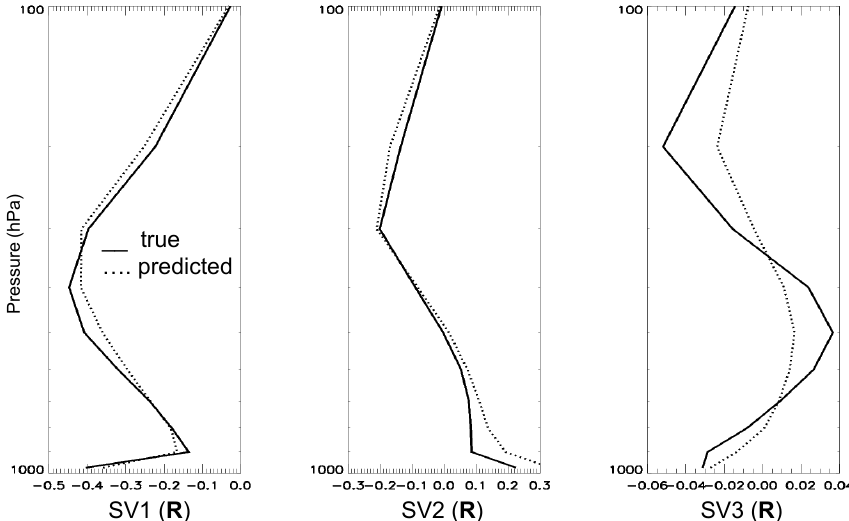
Fig. 9. Example of a test case to evaluate the prediction for singular vectors (SVs) for the rotated AK ( R ) for a single MOPITT observation. Solid lines indicate the true rows of R from the test case observation; dotted lines indicate the results of the prediction using MR coefficients from the training set and the state parameters from the test case observation as input.